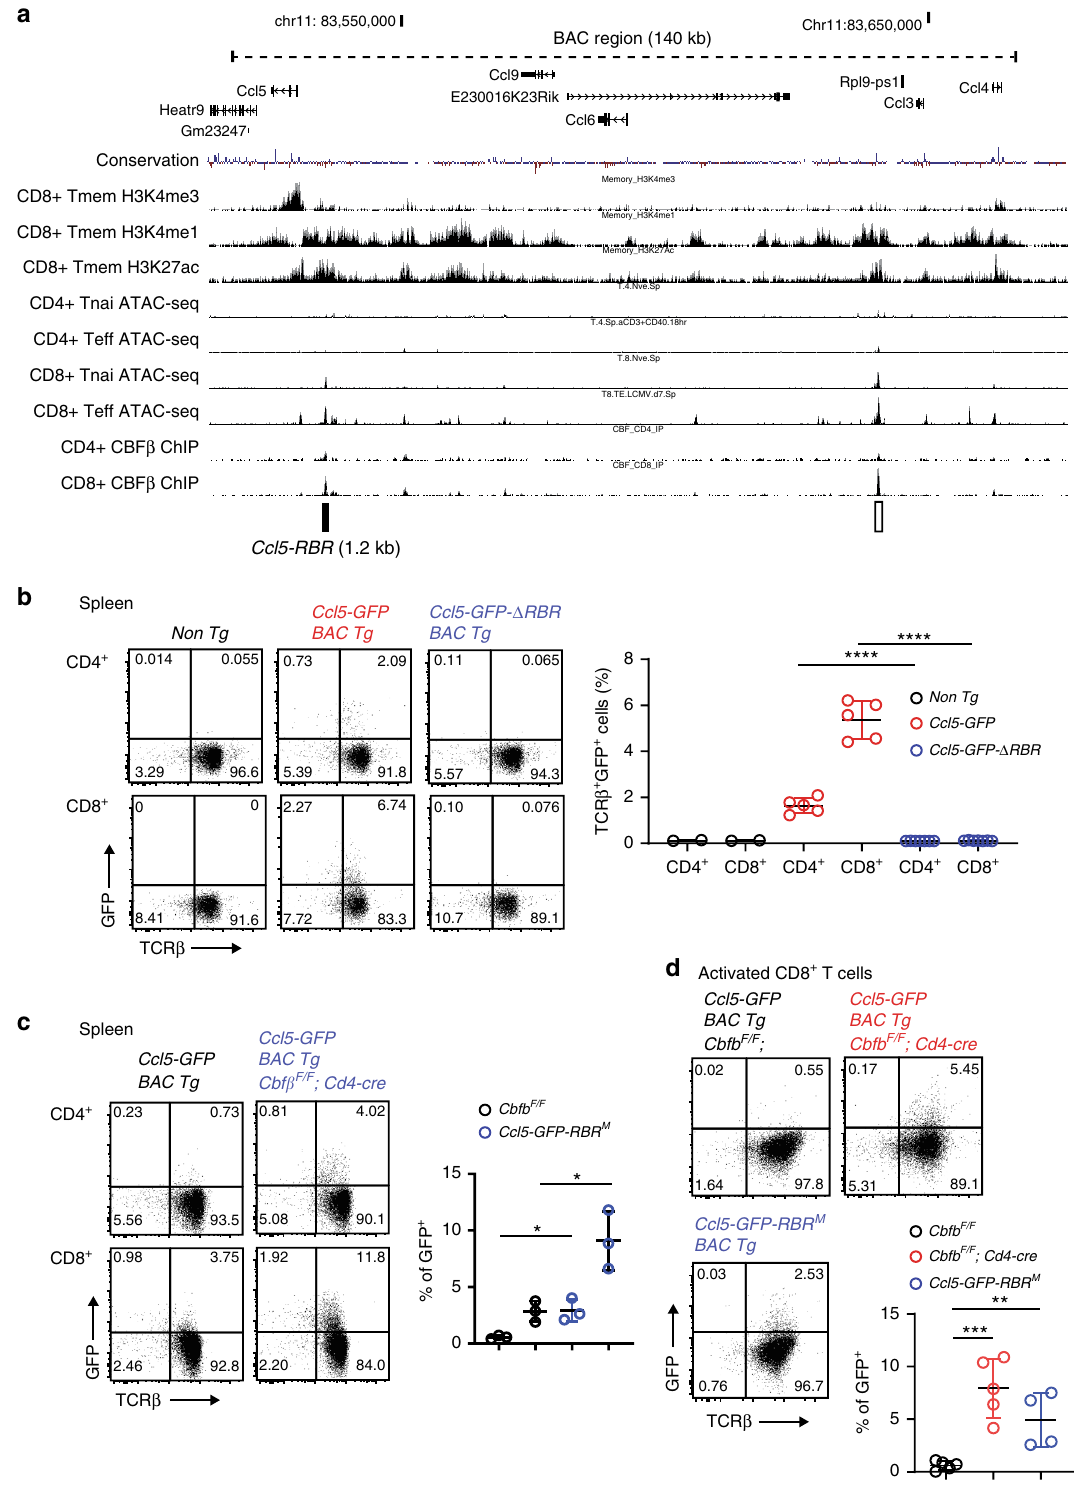
To ascertain whether and how RUNX complexes regulate Ccl5- RBR function, we monitored GFP expression in one representa- tive Ccl5-GFP BAC Tg line in the absence of CBF β expression by crossing with Cbfb F/F ; Cd4-Cre mice. While CD4 + T cells of BAC tg lines does not show appreciable amounts of GFP after activation, we observed an increase in GFP-expressing